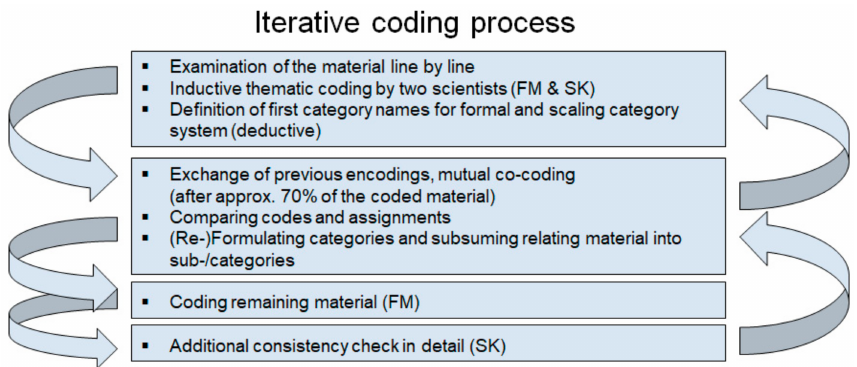
Figure 2. Qualitative content analysis: iterative coding process. Step 1: Two scientists with a background in healthcare science (F.M., male, PhD) and social science (S.K., female, M.Sc.) independently examined the material line by line, coded inductively with regard to the content (thematic coding) and formulated as closely to the notes as possible. Additionally, codes were scaled in accordance with Kurkowski et al. [16]. sections. Positive and negative connotations were differentiated (scaling). Codes were scaled to the category “positive rating” if they contained clearly positive expressions